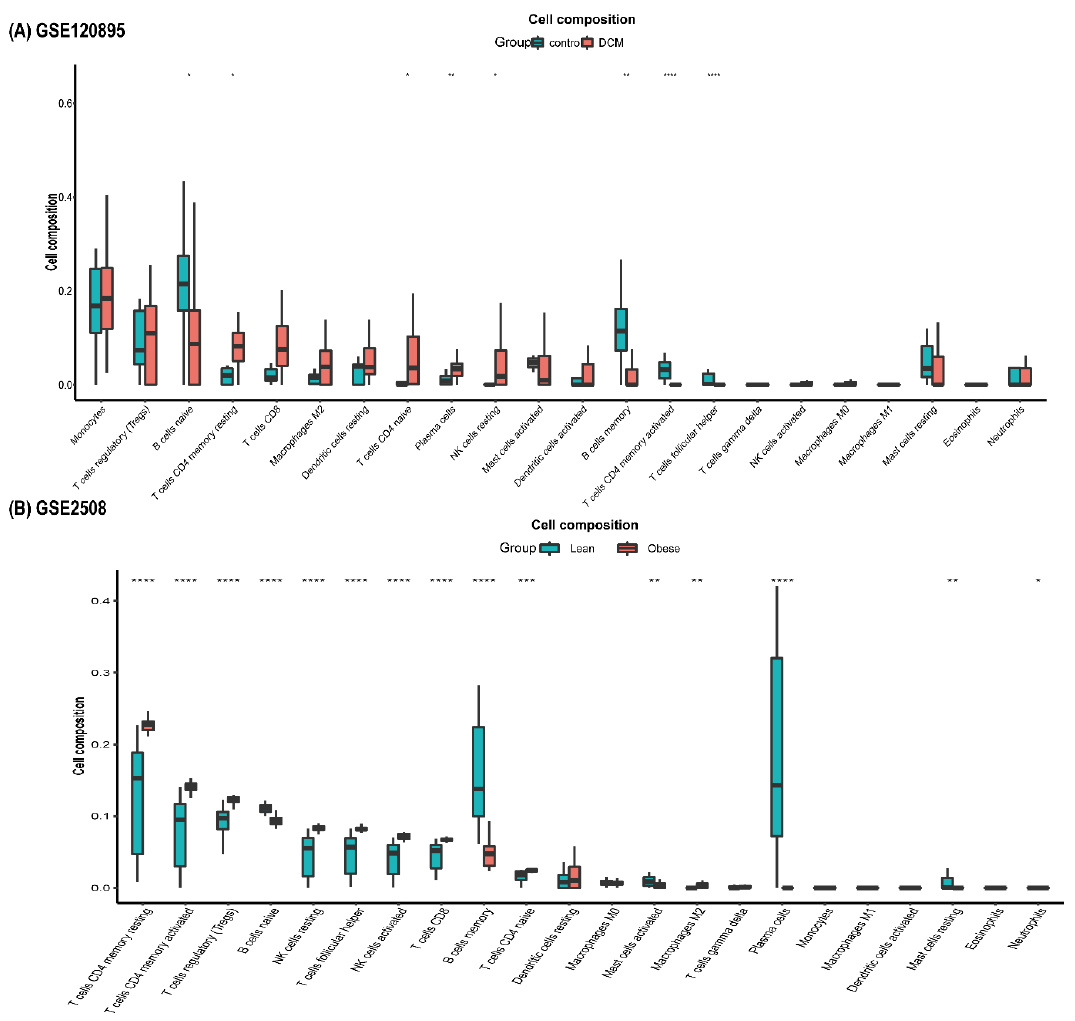
Figure 3. The boxplot of immune cells. ( A ) The boxplot of immune cells in GSE120895. ( B ) The box- plot of immune cells in GSE2508. * p < 0.05, ** p < 0.01, *** p < 0.001, **** p <